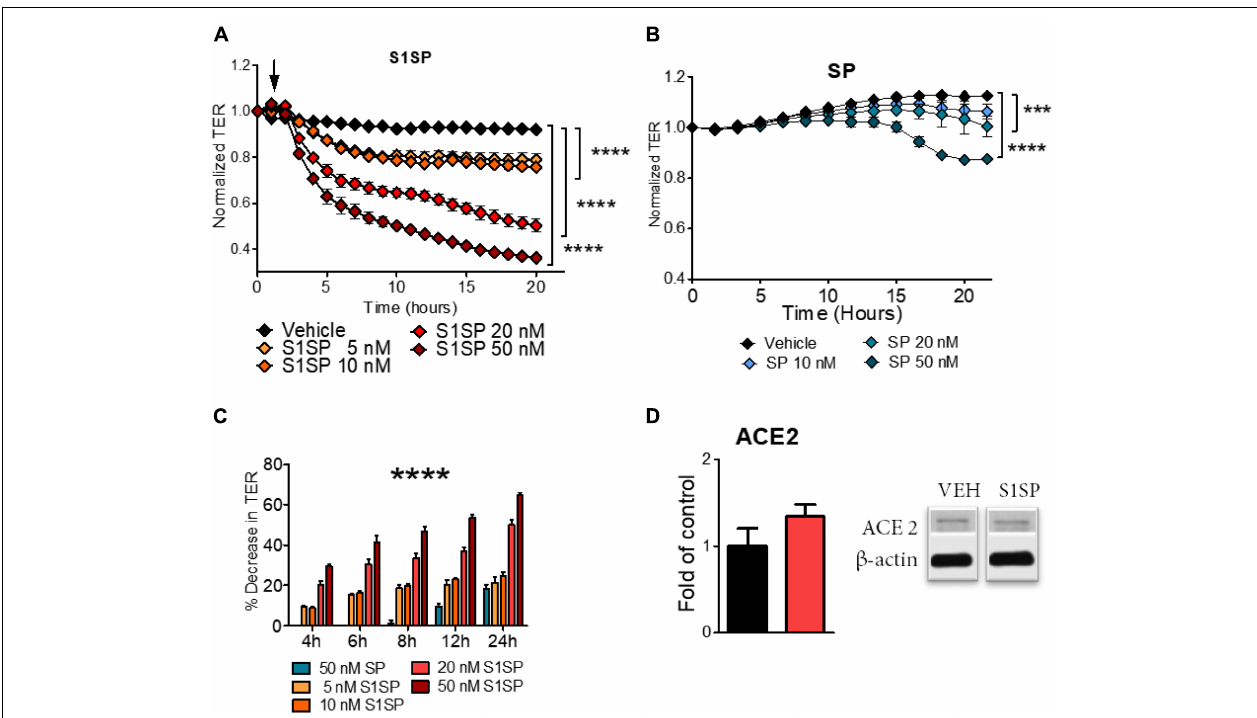
FIGURE 1 | Barrier dysfunction of human lung microvascular endothelial cells (HLMVEC) exposed to SARS-CoV-2 intact spike protein (SP) or to subunit 1 (S1SP). (A) Changes in transendothelial electrical resistance (TER) of HLMVEC after exposure to vehicle or different concentrations of S1SP (5–50 nM). (B) Changes in TER of HLMVEC after exposure to vehicle or different concentrations of SP (10–50 nM). (C) Percentage decrease in TER at different time points after S1SP or SP. (D) Expression of ACE2 in lysates of HLMVEC exposed to S1SP for 4 h. Data represent means ± SEM; n = 3–5; *** p < 0.001; **** p < 0.0001 between groups, 2-way ANOVA and Bonferroni’s post-test (A,B) , or 1-way ANOVA and Tukey’s test (C,D)